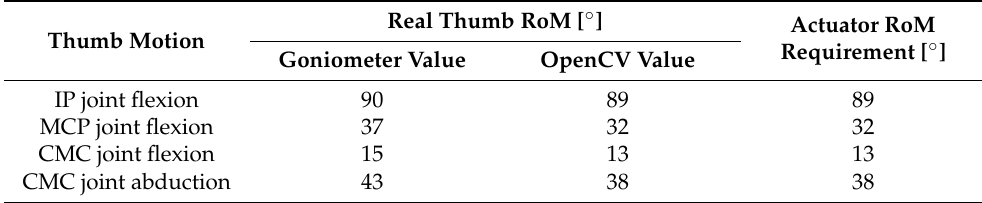
Table 1. RoM requirements of the thumb and actuators.